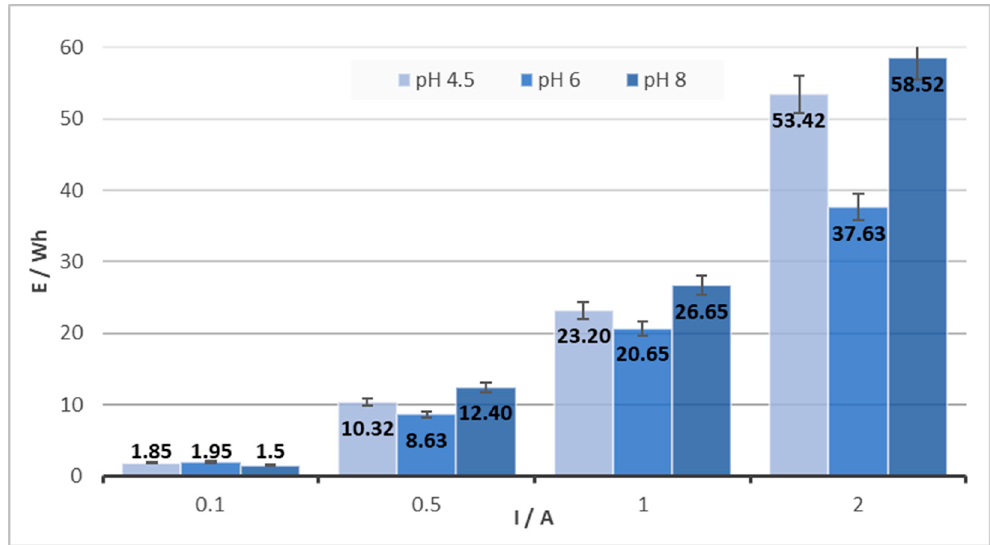
Figure 3. Energy consumption for the solution c(Cr(VI)) = 1000 mg/L and c(NaCl) = 3000 mg/L.